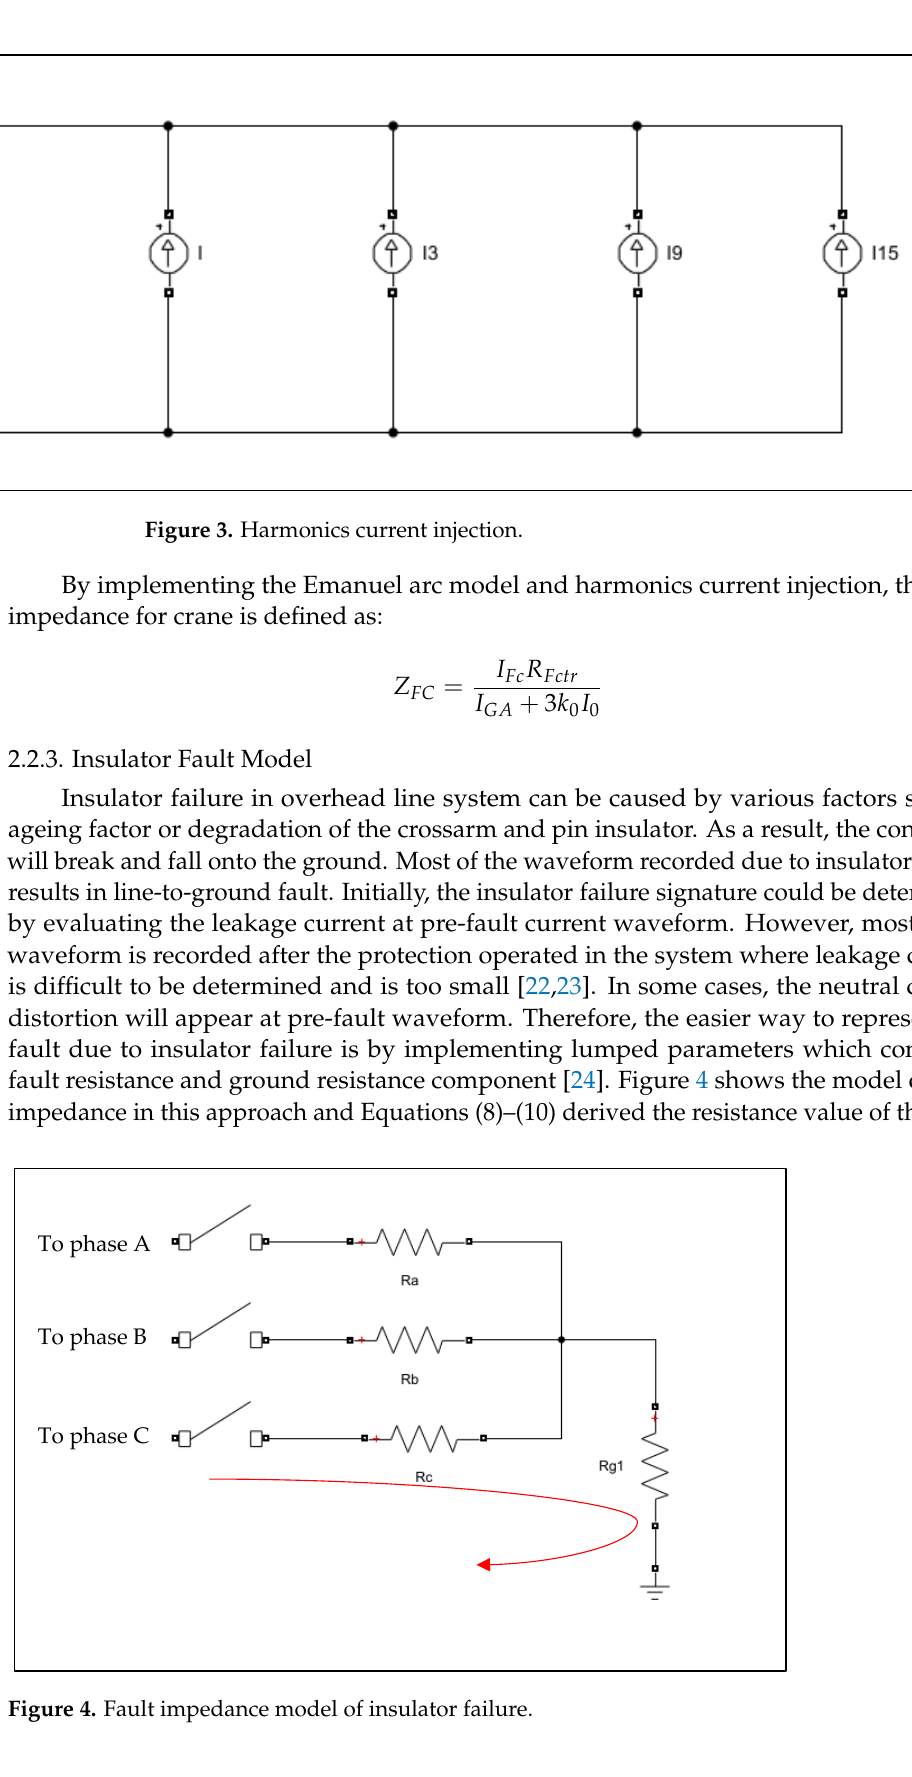
Figure 4. Fault impedance model of insulator failure.